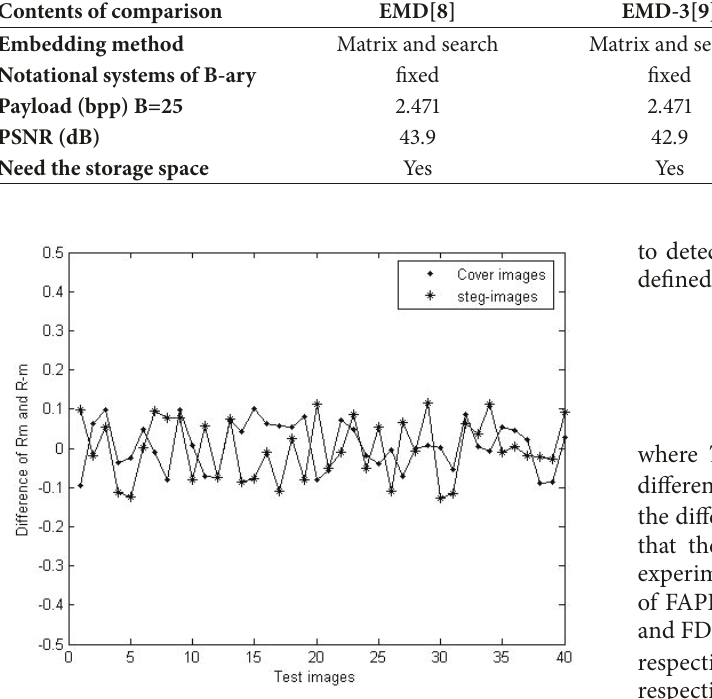
Figure 7: The difference of Rm and R-m for RS attack.